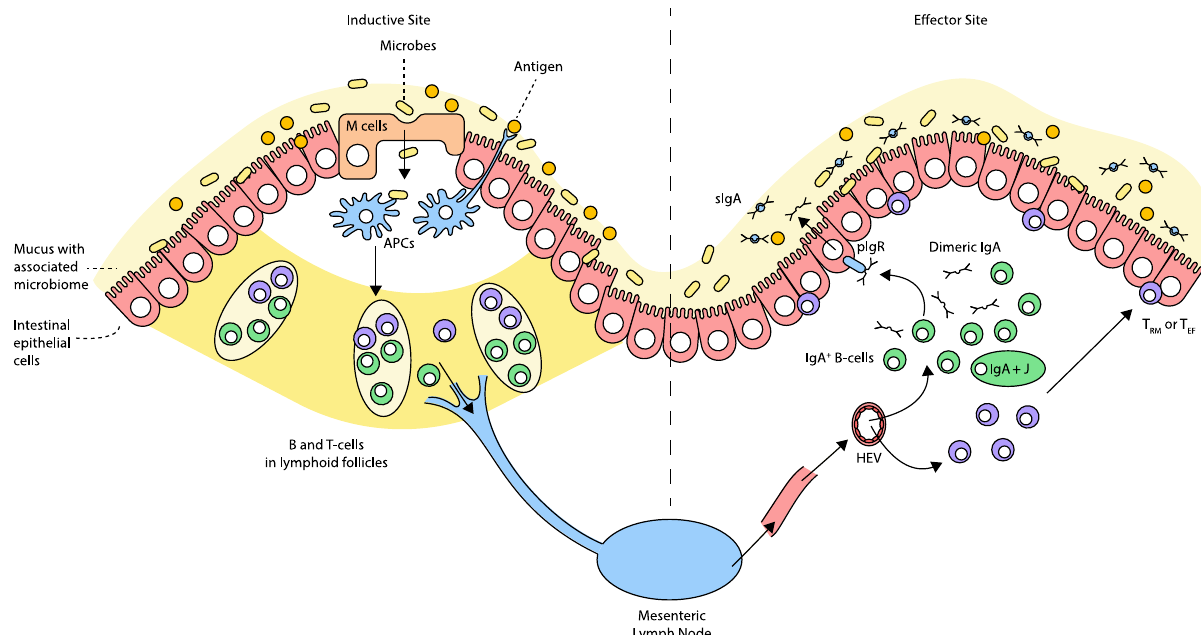
Fig. 1 MALT and mucosal immune response. The MALT can be functionally divided into 2 portions, the inductive and the effector sites. The organized lymphoid tissue composed of lymphoid follicles, present along the GIT (GALT) and the respiratory tract (NALT) represent the inductive sites where immune response is initiated. Overlying the follicles are specialized epithelium which in the Peyer ’ s patches is called the follicle-associated epithelium (FAE). This overlying epithelium is equipped with functionally active microfold cells (M cells) which are involved in antigen sampling from the lumen and delivers these luminal antigens to the underlying DCs and macrophages (APCs) in the subepithelial follicles via transcytosis. Some of the underlying DCs and Macrophages also directly sample antigens from the lumen by the extension of transepithelial dendrites across the epithelium or by occasional migration into the lumen. Following antigen capture, the APCs delivers and present the antigens to the T cells and B cells present in the follicles to induce an antigen-speci fi c immune response. The activated T and B cells then exit the submucosa via the lymphatics to the mesenteric lymph nodes where the immune response may be further exaggerated before fi nally draining into the systemic circulation. These activated cells then express mucosal homing receptors such as CCR9 and CCR10 and are guarded by gradient of chemokines such as CCL25 and CCL28 present in the mucosa to fi nally exit the blood, a process mediated by integrins and adhesion molecule α 4 β 7 and MAdCAM-1 respectively. At the effector site where the effector functions are carried out, activated T cells go on to become effector cells and/or tissue-resident memory cells. Activated B cells undergo class-switch to become IgA + B cells and plasma cells which add joining chains to secrete polymeric IgA. These polymeric IgA are transported transcellular to the lumen following binding to polymeric Ig receptor (pIgR) as secretory IgA (sIgA) which lines the mucus and functions in trapping